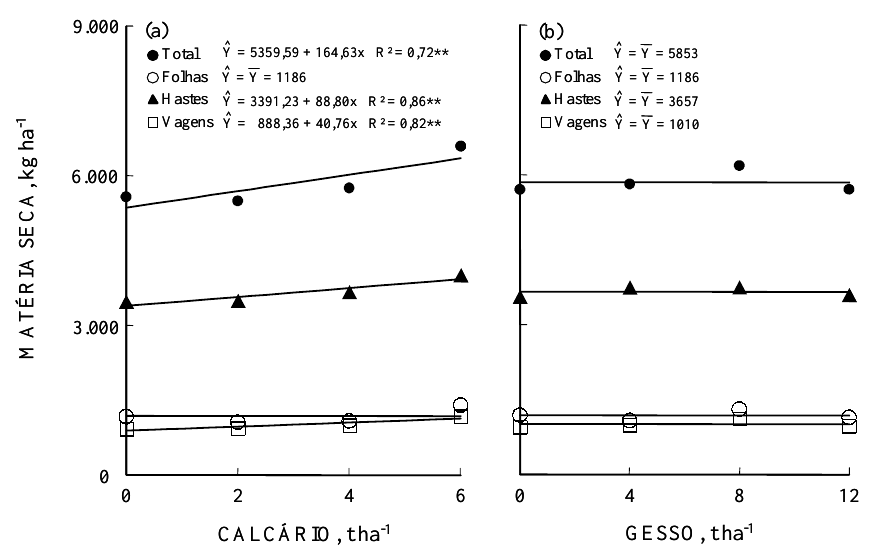
Figura 2. Efeito de doses de calcário (a) e de gesso (b) na produção de matéria seca total e de partes da planta de soja. ** significativo a